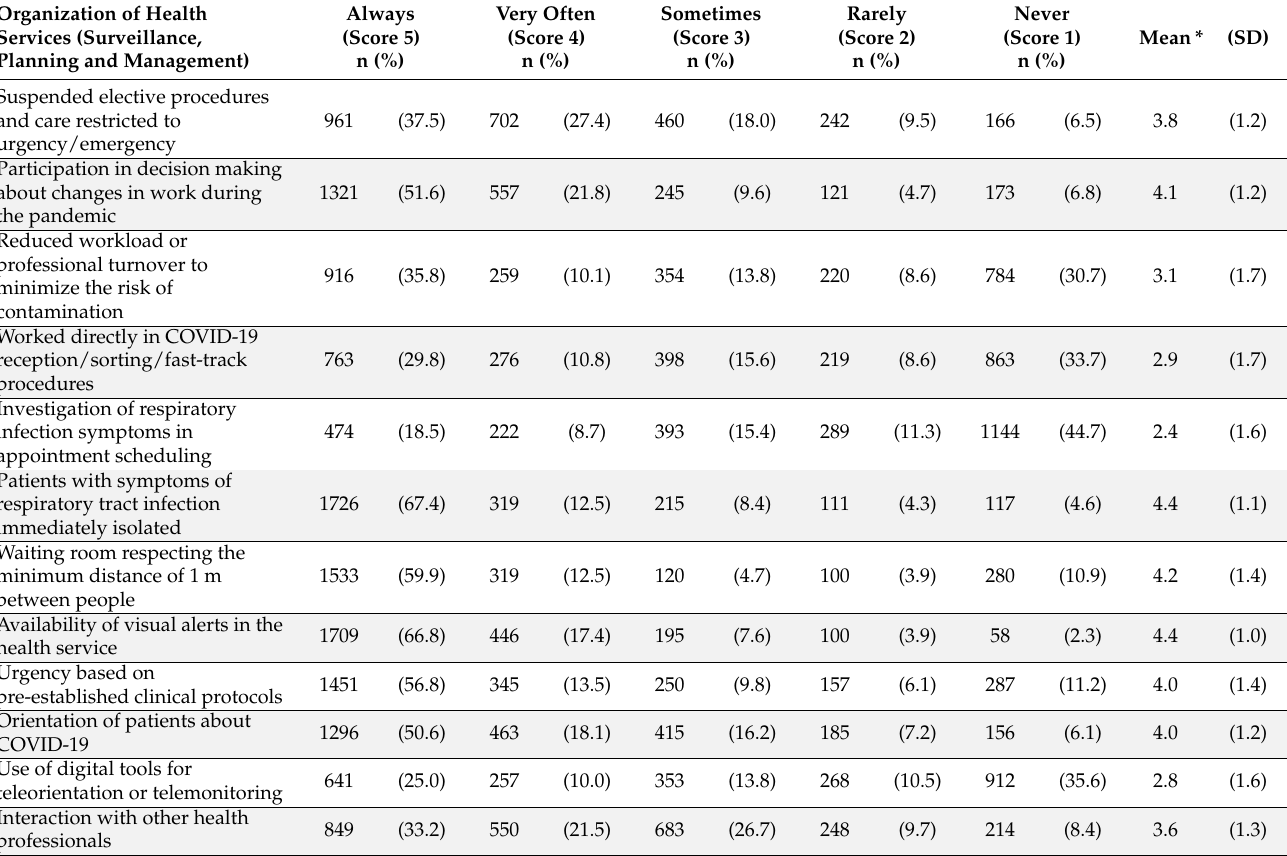
Table 2. Sample of oral health care workers’ distribution regarding the adoption of surveillance, planning and risk management measures to control the dissemination of COVID-19 in health services. Brazil, August–October,